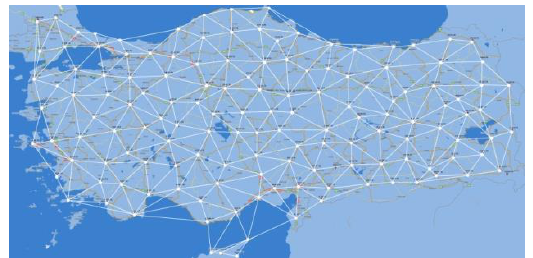
Figure 1. CORS-TR Stations